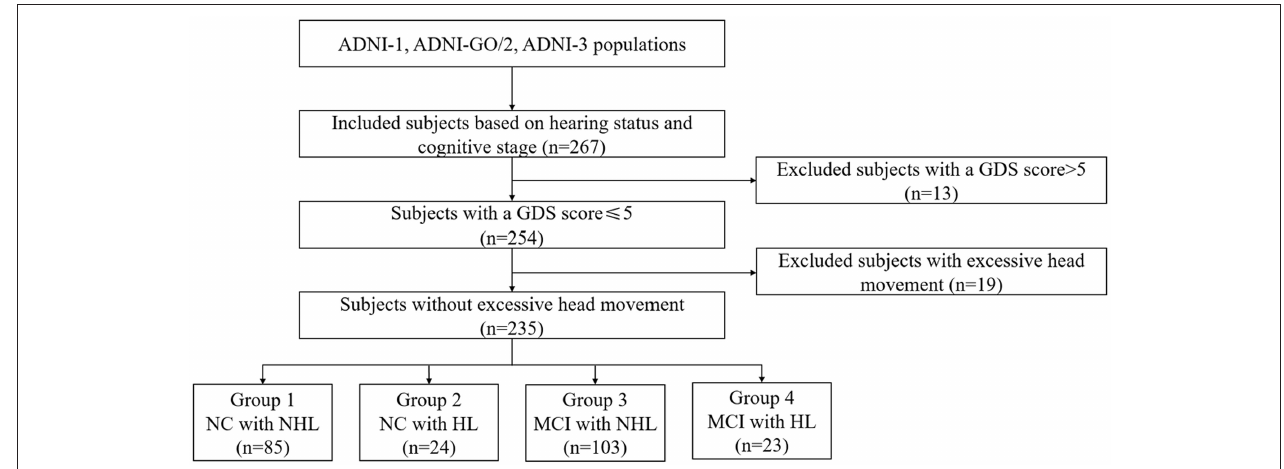
FIGURE 1 | Schematic flow diagram of the sample size. NC, normal cognition; MCI, mild cognitive impairment; HL, hearing loss; NHL, no hearing loss; GDS, Geriatric Depression